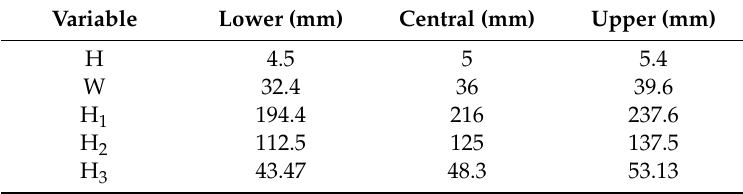
Table 3. Central composite design for five geometrical variables.